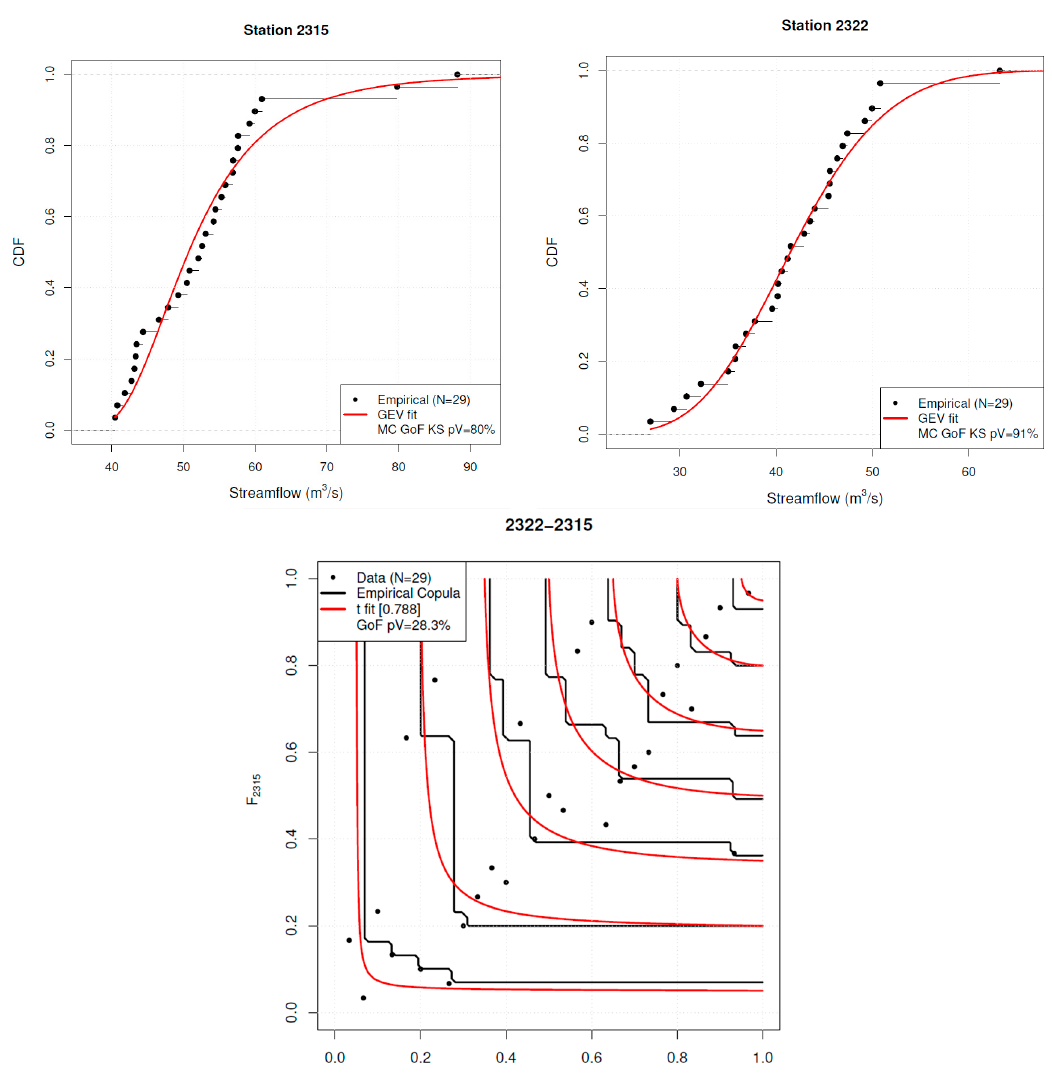
Figure 7. Lower Çoruh basin. ( Top row ) GEV fits of the 7-day low flow series in the lower Çoruh basin. Shown: the empirical CDF (black markers), the fitted CDF (red line), the sample size N and an approximate Monte Carlo Goodness-of-Fit test p -value of Kolmogorov–Smirnov type. ( Bottom row ) Copula fit. Shown: the pseudo-observations (markers), the empirical copula (black lines) and the fitted copula family (red lines). Additionally shown are the sample size N, an MLE estimate of the copula parameter and an approximate Monte Carlo Goodness-of-Fit test p -value of Cramér-von Mises type.